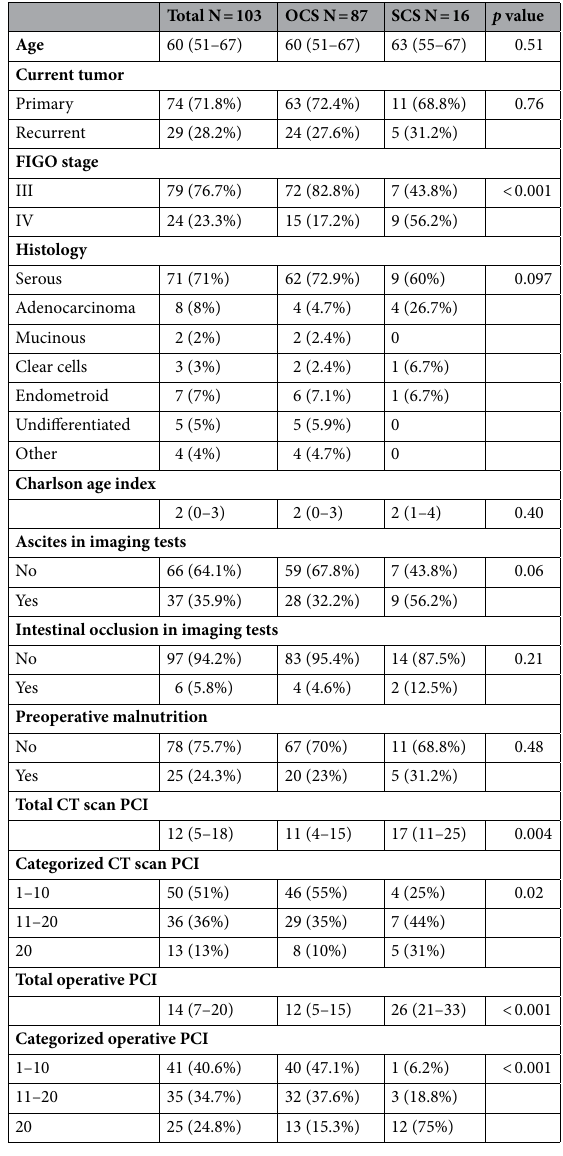
Table 2. Characteristics of the patients. *Data are presented as n (%) and median (interquartile range).